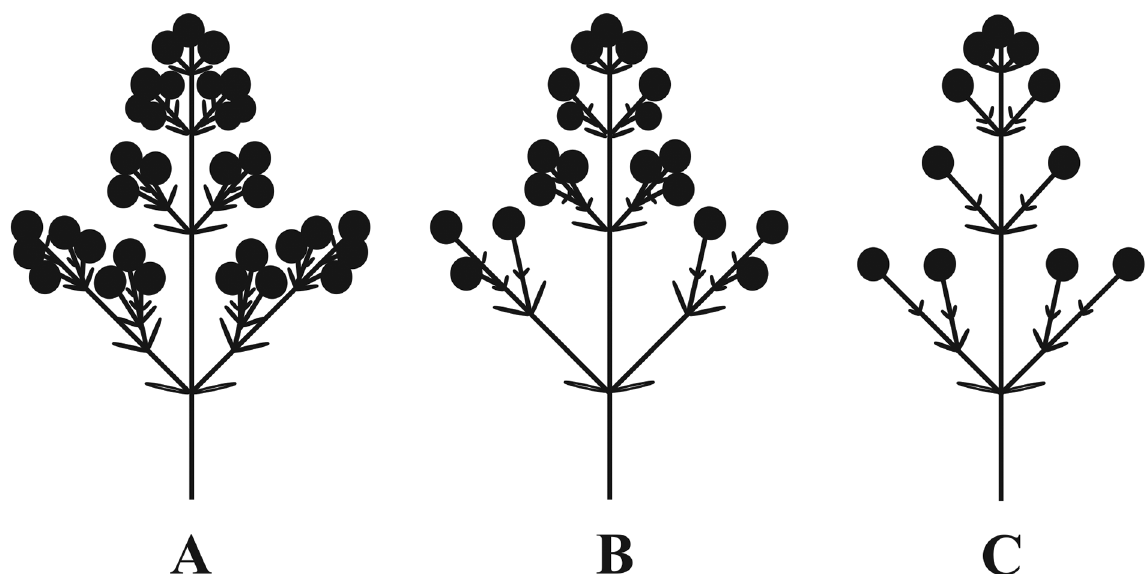
Fig. 4. Thyrsoid synflorescences of the chasmophytic species. A . S. parrowiana Boiss. & Hausskn., dense form with short pedicels and many flowers. B . S. penduliflora F.Jafari, Keshavarzi & Doostm. sp. nov., lax form with long pedicels and peduncles. C . S. thyrsiantha F.Jafari, Mirtadz. & Keshavarzi sp. nov., reduction in number of